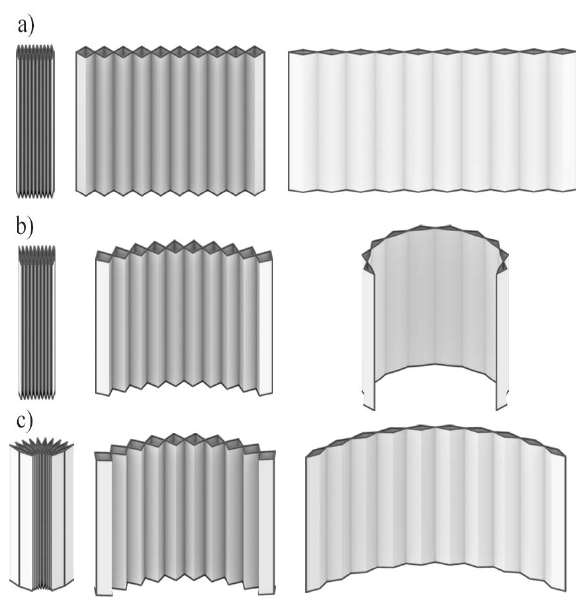
Figure 3: Deployment sequences of uniaxial transformation struc- tures consisting of a) translational, b) polar and c) angulated scissor linkages